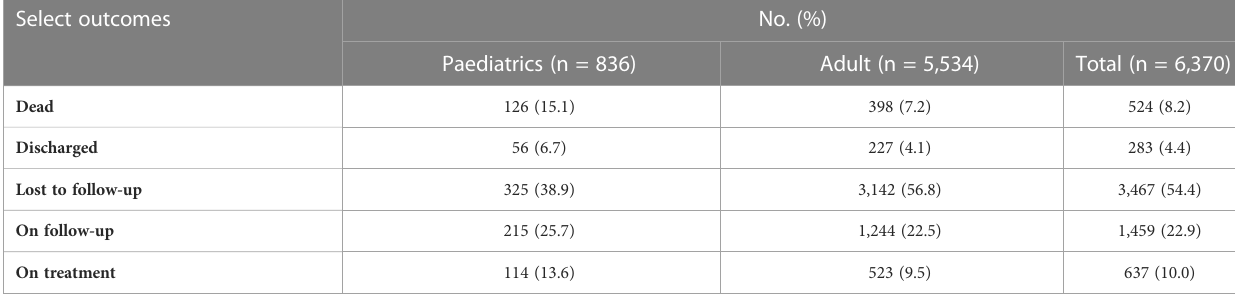
TABLE 2 Distribution of select outcomes among paediatric, adult, and total patients. Select outcomes